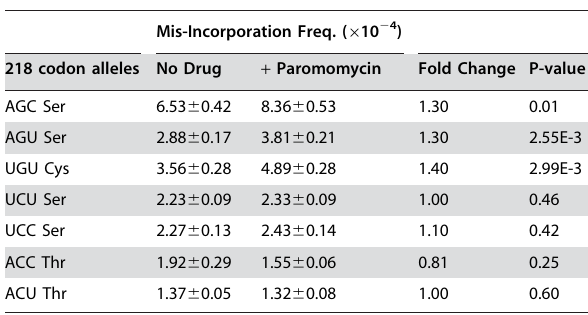
Table 1. Baseline levels and effects of paromomycin on suppression of missense mutations at codon 218 of